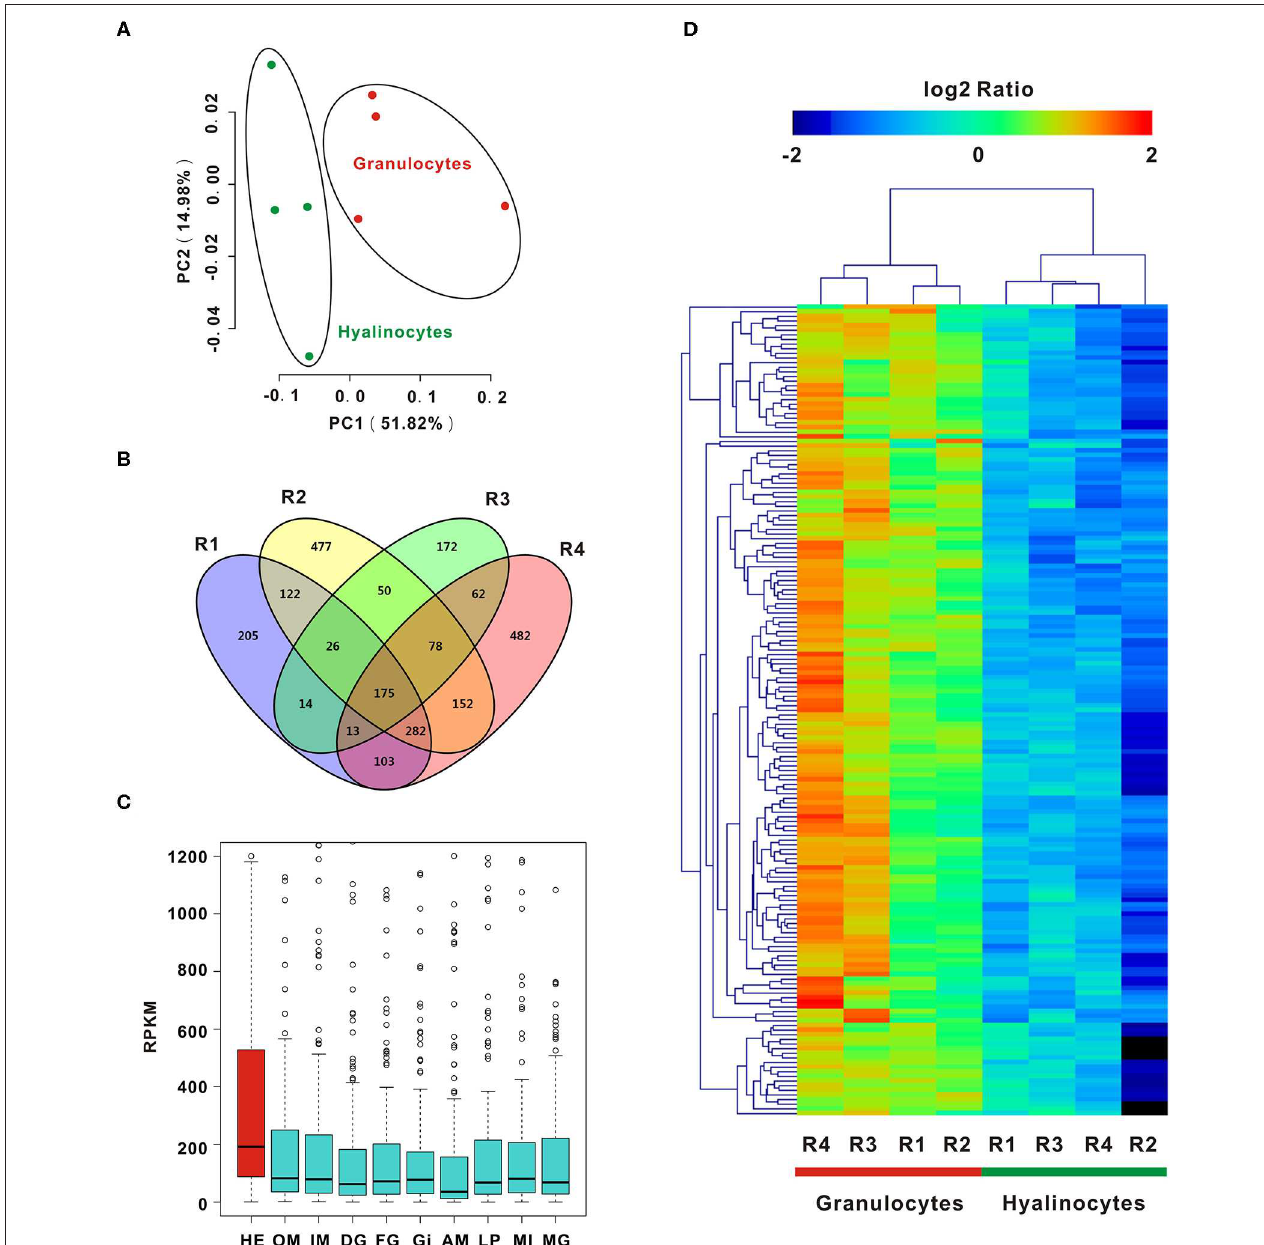
FIGURE 2 | PCA and DEGs analysis of C. gigas granulocytes and hyalinocytes. (A) Scores plot of principal components analysis on C. gigas hemocyte subpopulations (granulocytes and hyalinocytes). PC1 and PC2: principal component 1 and principal component 2. Each point represents a metabolite profile of a biological replicate. (B) DEGs were first explored in each group for comparison between granulocytes and hyalinocytes. Venn diagram was constructed to determine common DEGs in the four groups (R1, R2, R3, and R4). (C) Tissue distribution of DEGs in C. gigas . Red box represents the high expression of DEGs in hemocytes. HE, hemocytes; OM, outer mantle; IM, inner mantle; DG, digestive grand; FG, female gonad; GI, gill; AM, adductor muscle; LP, labial palps; MI, mixture of adult tissues; MG, male gonad. (D) Data for relative expression levels of genes were obtained by DEGs data. Colors from red to blue indicate range of log 2 ratio values (in descending order); red color indicates high expression level and blue color indicates low expression level.